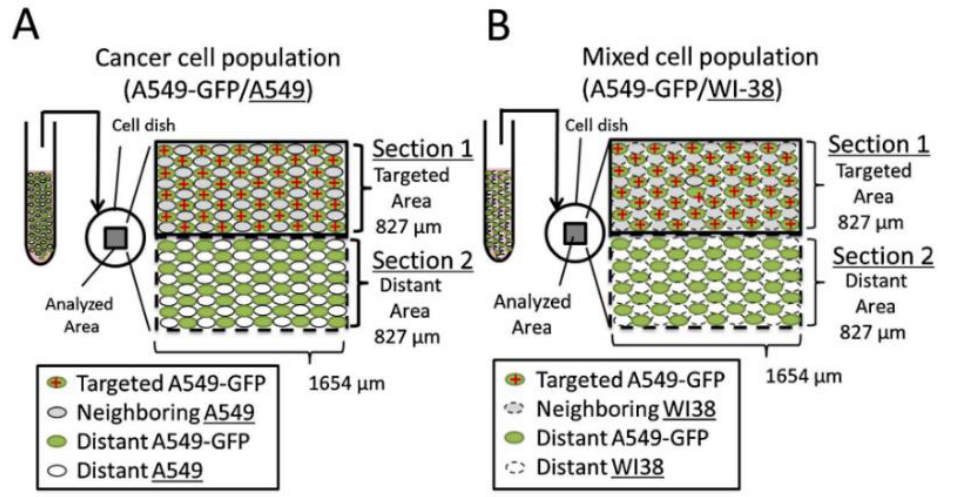
Figure 4. Experimental scheme employed in the work of Kobayashi et al. [52]. Each cell dish was divided into two halves, with one half (Section 1) containing both targeted and non-targeted cells while the other half (Section 2) contained only non-targeted cells. Only A549-GFP cells (stably expressing H2BGFP) in Section 1 were targeted in the experiments. There were thus three different types of cells in the co-cultures, namely, (i) targeted A549-GFP cells in Section 1, each of which was irradiated with 500 protons; (ii) non-targeted A549 cells (in the cancer cell population ( A )) or non- targeted WI38 cells (in the mixed cell population ( B )), both of which were “neighboring” and having direct contact with the “targeted” A549-GFP cells in (i); and (iii) non-targeted A549-GFP cells, A549 cells, or WI38 cells in Section 2, which were also referred to as the “distant” non-targeted A549-GFP, A549, or WI38 cells, respectively, and were not in direct contact with the “targeted” A549-GFP cells in (i). (Adopted from ref. [52]; permission to reuse obtained from Elsevier).